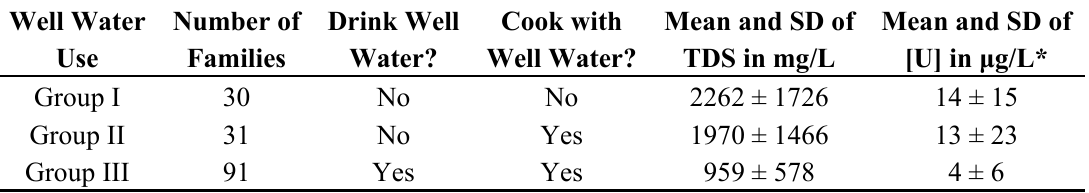
Table 1. Relationship of well water quality to